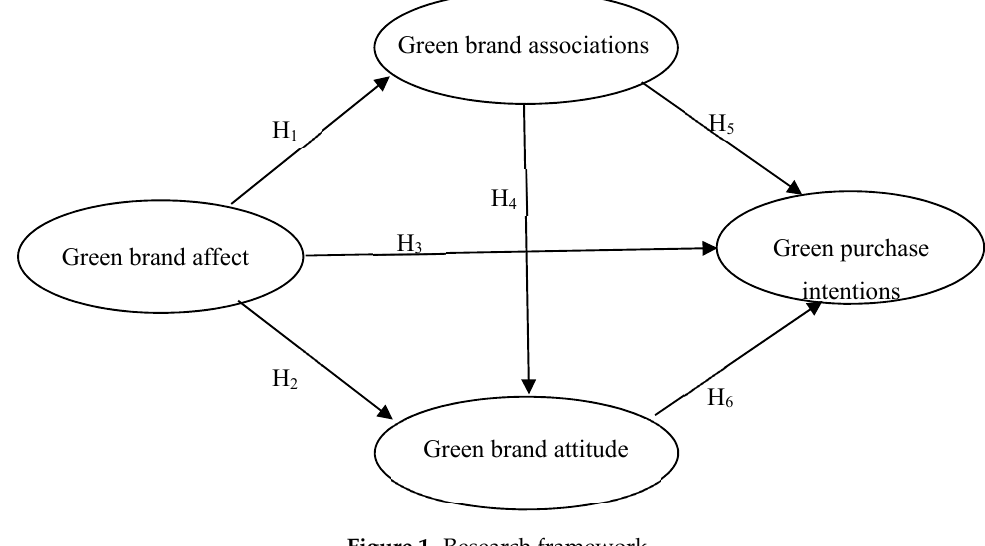
Figure 1. Research framework.